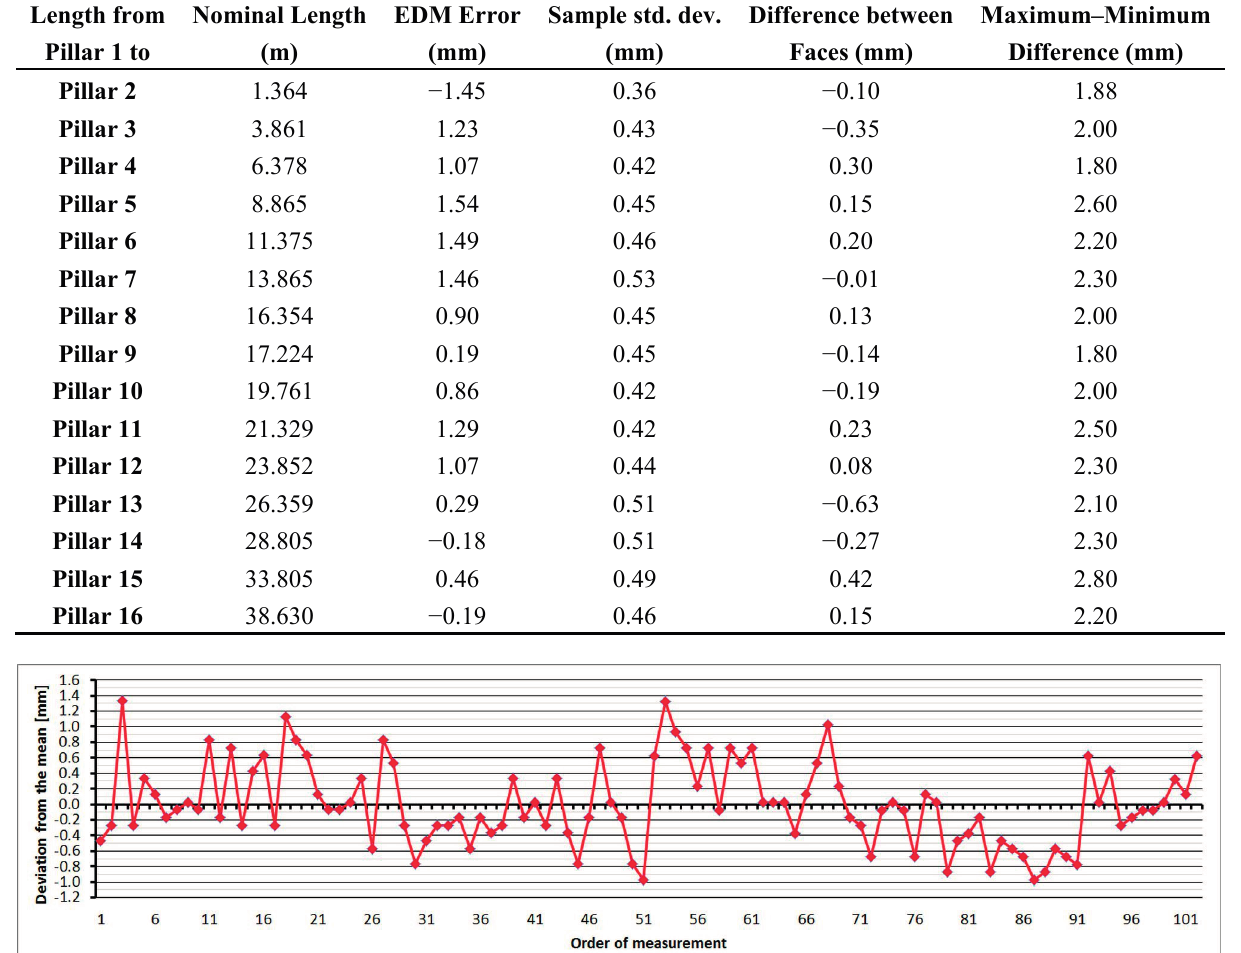
Figure 13. Trimble M3–Differences from average distance–pillar 7 (13.9